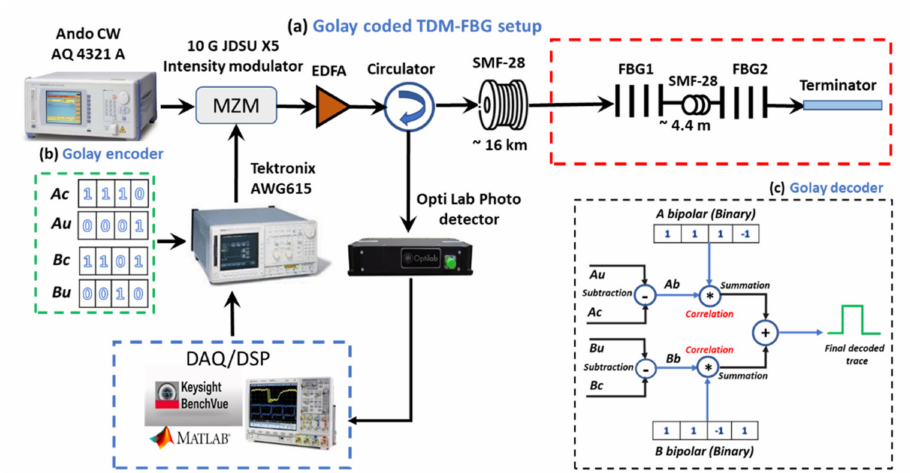
Figure 2. Experimental setup used to perform the 4–256 bit Golay coded TDM-FBG sensor. ( a ) Experimental setup: ( b ) Golay encoder; ( c ) Golay decoder. CW: continuous wave; MZM: Mach– Zehnder modulator; AWG: arbitrary waveform generator; EDFA; erbium-doped fiber amplifier; FBG: fiber Bragg grating; DAQ: data acquisition; DSP: digital signal processing; A u & B u : unipolar forms of GCP; A c & B c : their